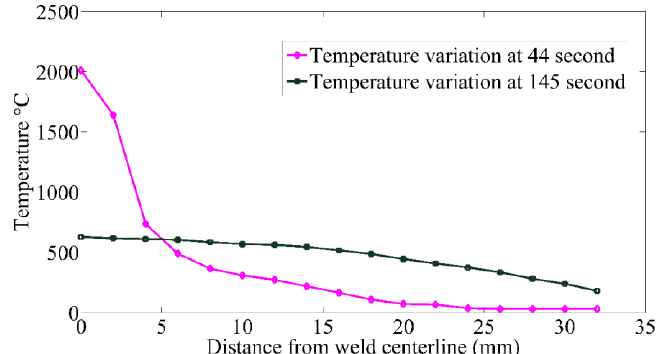
Fig. 12. Temperature variation in the longitudinal weld joint at different time frames.